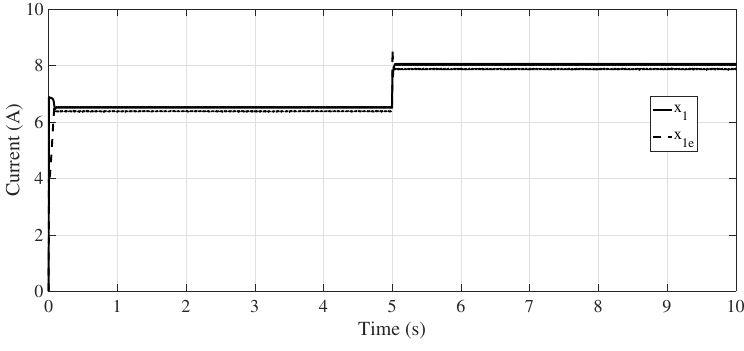
Figure 7. PV current.